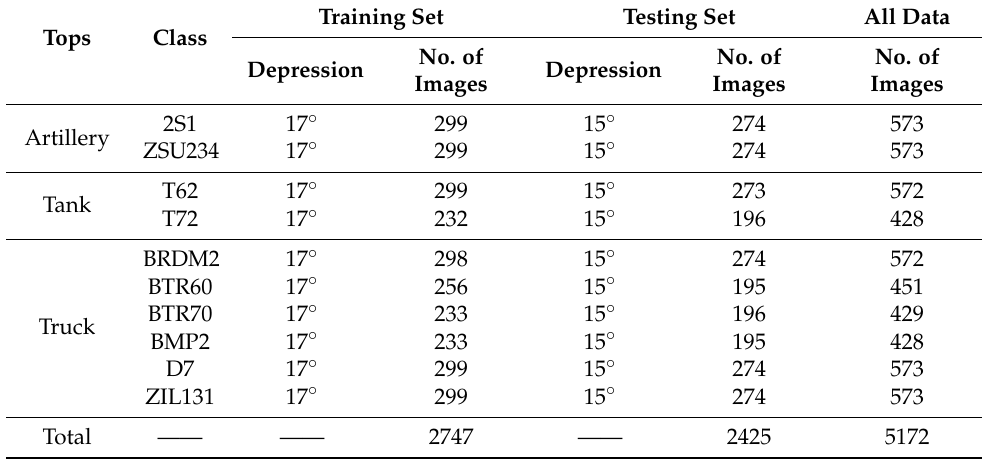
Figure 3. Optical images and corresponding SAR images of ten classes of objects in the moving and stationary target acquisition and recognition (MSTAR) database, ( a ) 2S1; ( b ) BMP2; ( c ) BRDM2; ( d ) BTR60; ( e ) BTR70; ( f ) D7; ( g ) T62; ( h ) T72; ( i ) ZIL131; ( j ) ZSU234. Table 1. Detailed information of the MSTAR data set used in our